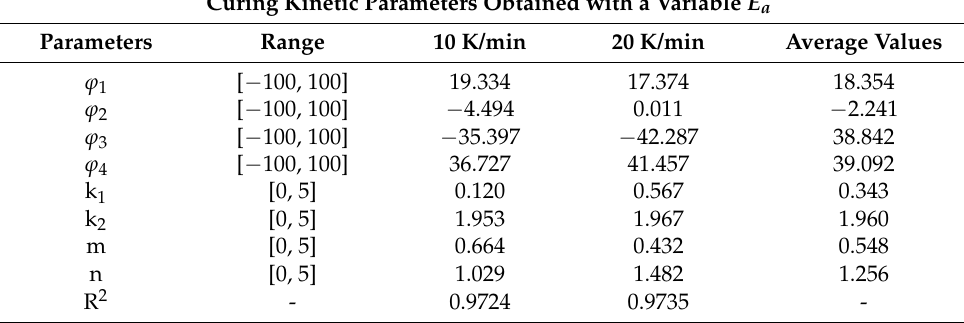
Table 4. Kamal autocatalytic model parameters of ultrasonic